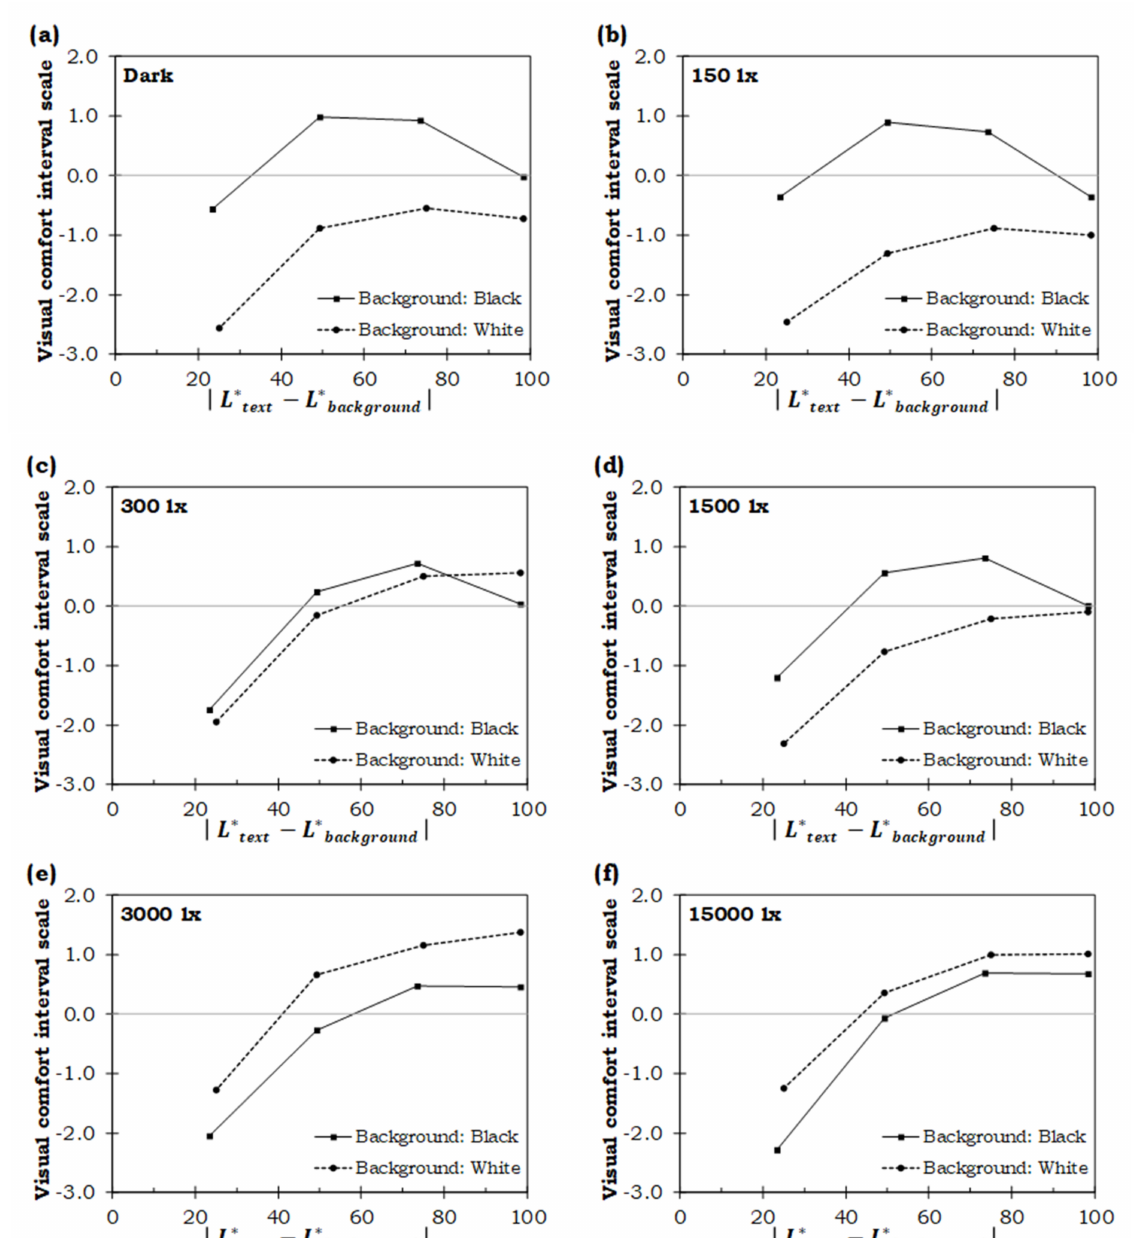
Figure 7. Visual comfort interval scale of the text-background combination with white and black background under six lighting conditions ( a ) Dark ( b ) 150 lx ( c ) 300 lx ( d ) 1500 lx ( e ) 3000 lx ( f ) 15,000